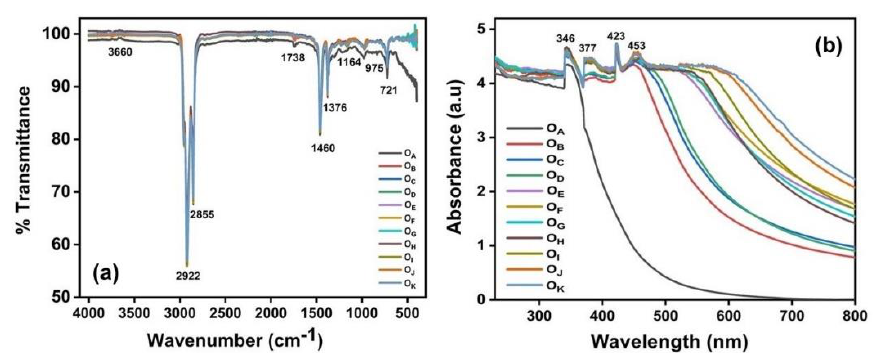
Figure 4. ( a ) FTIR spectra and the ( b ) UV-Vis spectra of the samples. The IR bands in the region 2922 cm −1 , 2855 cm −1 and 1460 cm −1 , 1376 cm −1 , and 721